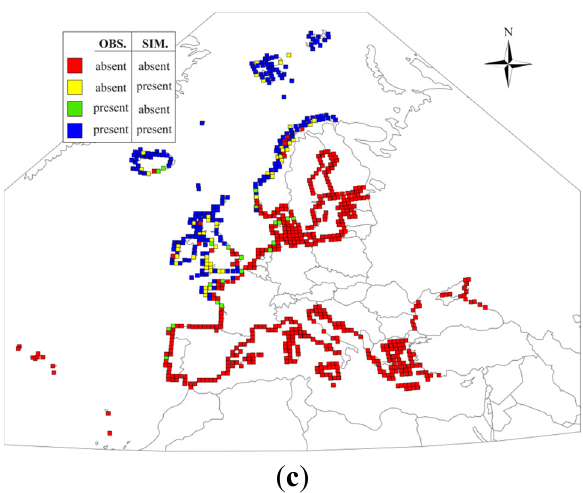
Figure 1. The potential European breeding distribution of the Black-legged Kittiwake in 2100 under emissions scenarios A1b ( a ) and A2 ( b ) based on climatic suitability predicted for the climatic scenarios derived from three General Circulation Models (GCMs) (yellow—unsuitable under all three GCMs; light green—suitable under one GCM; dark green—suitable under two GCMs; dark blue—suitable under all three GCMs); The observed (OBS) and simulated (SIM) distributions in 1985 are also shown for comparison ( c